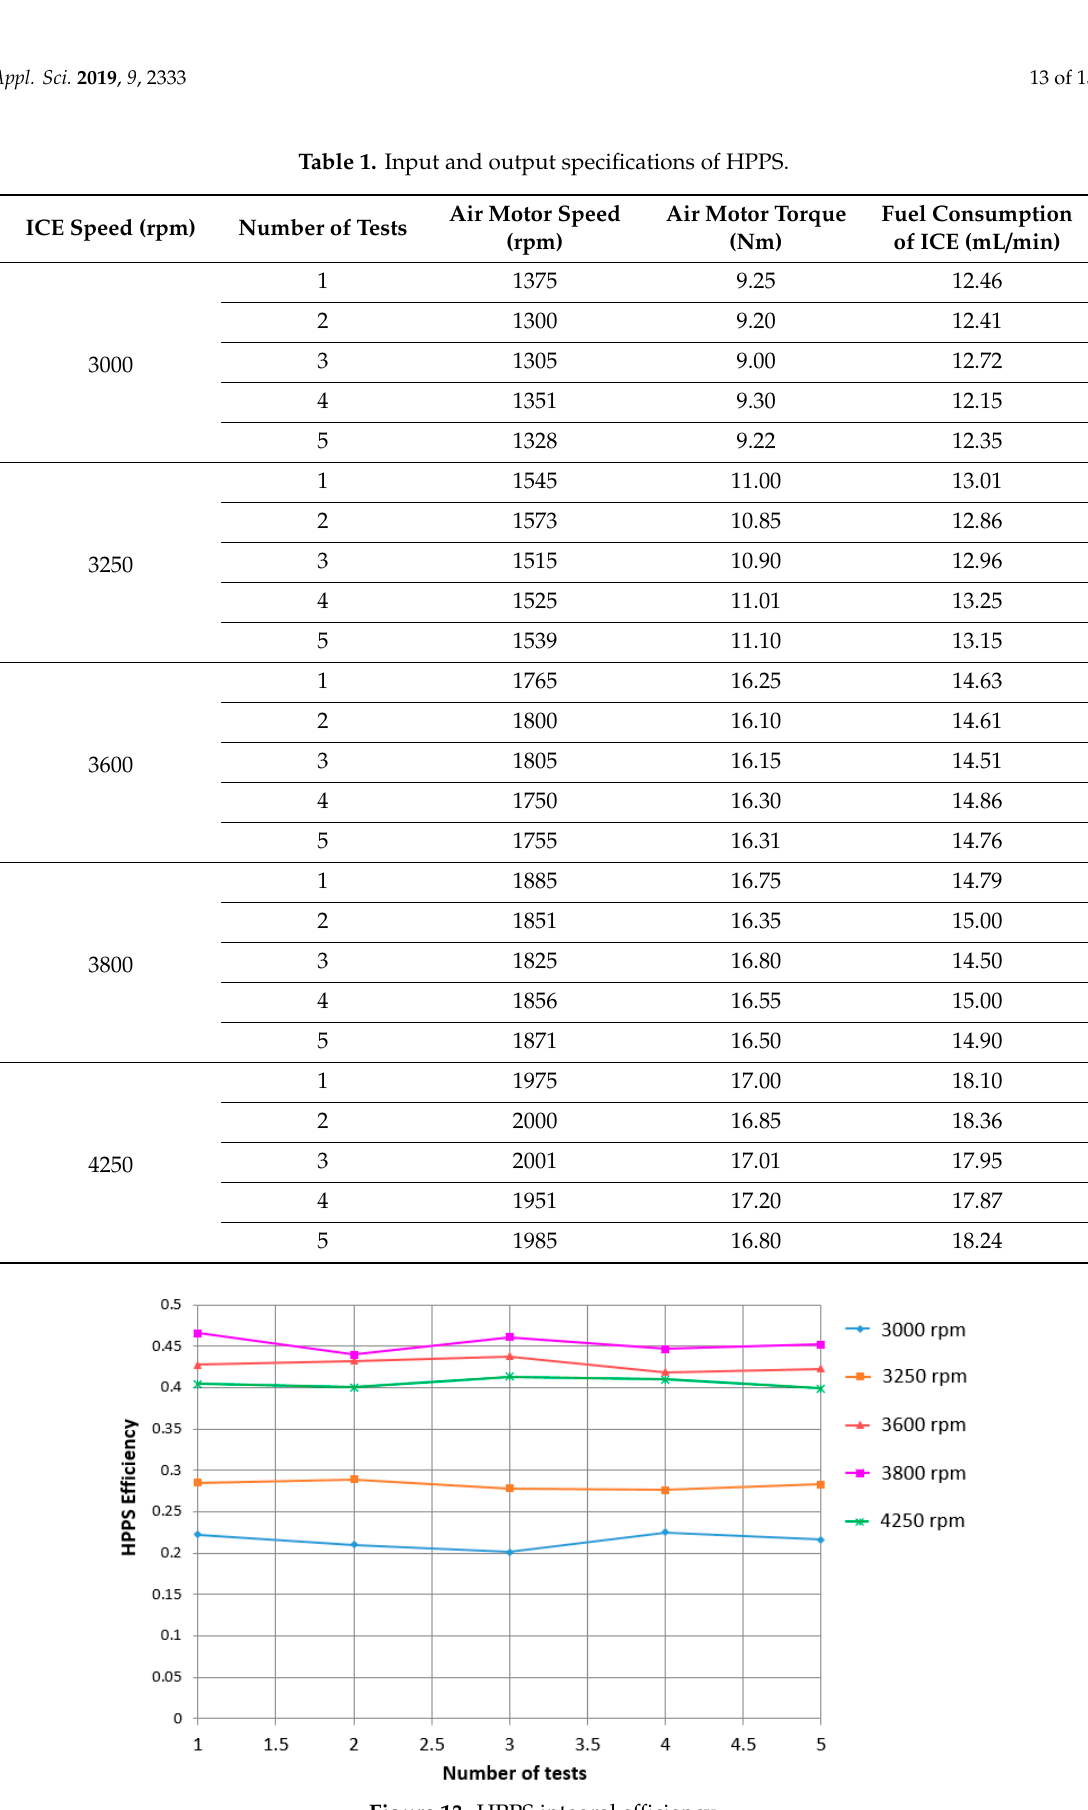
Figure 13. HPPS integral efficiency.